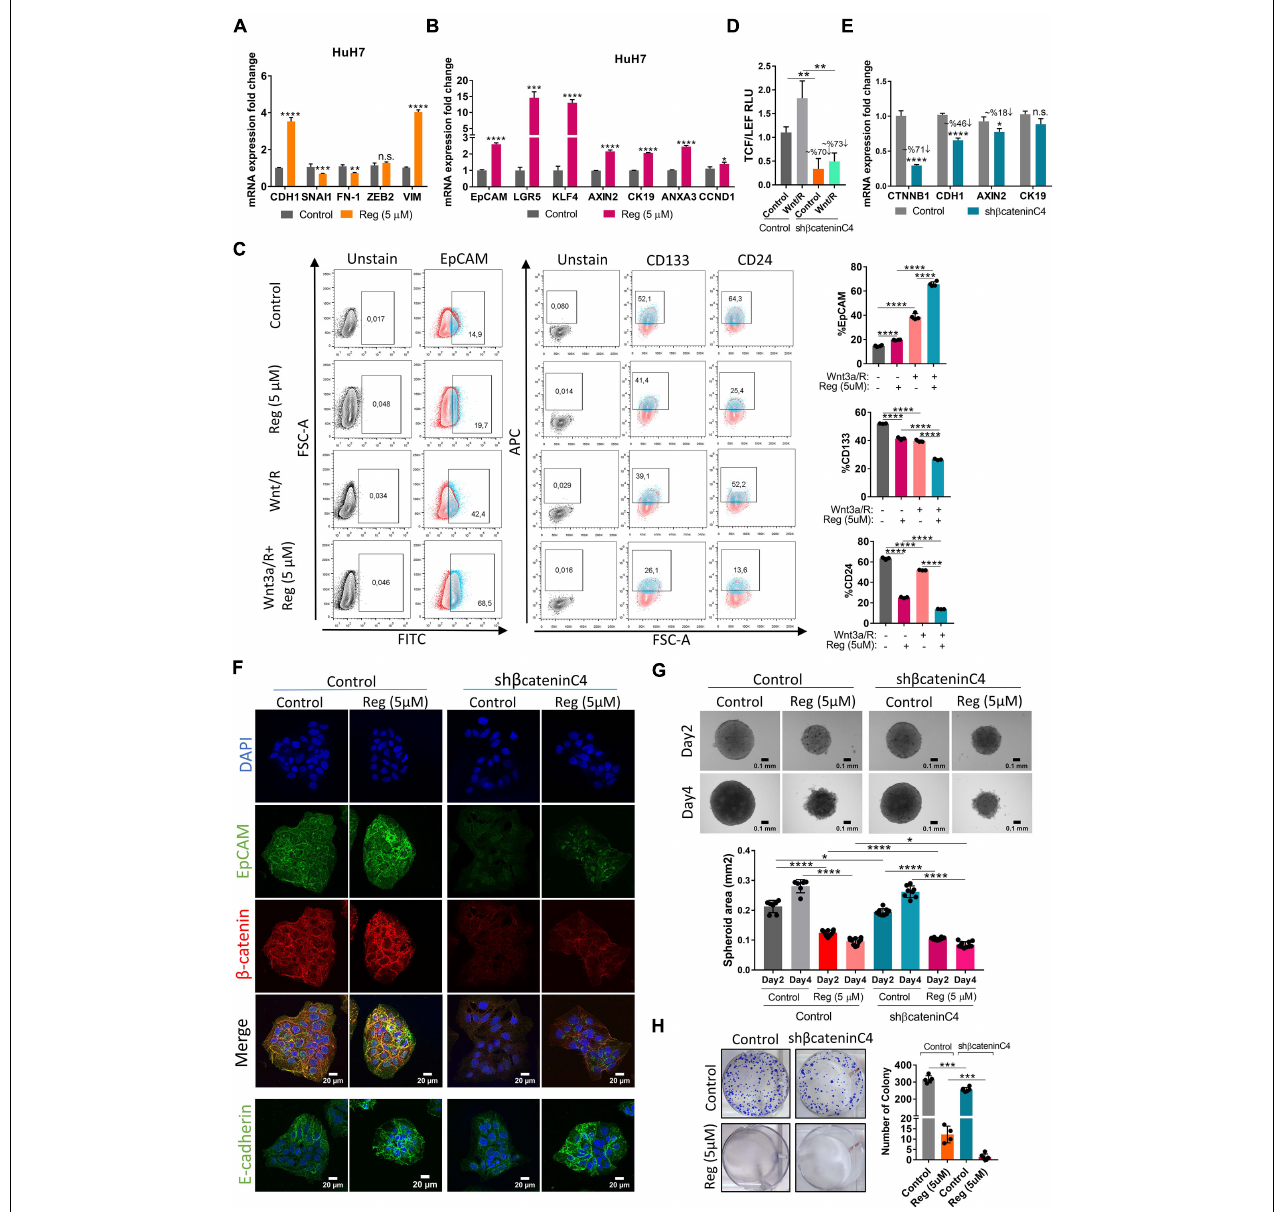
FIGURE 3 | Regorafenib treatment induces epithelial and stemness related gene expression. (A) Expression of mesenchymal and epithelial genes as well as (B) hepatic stem/progenitor genes were analyzed by q-PCR. Data represent the average of at least three independent experiments. (C) Cancer-stem cell marker (EpCAM, CD133 and CD24) positive cell populations were analyzed via BD LSR Fortessa flow cytometer with or without Wnt3a/R-Spo1 and regorafenib treatments. (D) TCF/LEF reporter activity in Wnt3a/R-Spo1 treated and untreated control and β -catenin knocked down cells (E) Expression of Wnt/ β -catenin target genes were analyzed by q-PCR. (F) Expressions of EpCAM, E-CAD and β -catenin were analyzed in control and β -catenin knocked down cells by immunofluorescence. Images were acquired on a Carl Zeiss LSM 880 AxioObserver confocal microscope with a C-Apochromat 40x/1.2 W, Korr FCS M27 objective. (G) 3D spheroids were formed from control and β -catenin knocked down cells with or without regorafenib treatment. Spheroid area was calculated using Image J. (H) Colony formation assay was performed using control and β -catenin knocked down cells with or without regorafenib treatment. p > 0.05 (n.s.), p ≤ 0.05 (*), p ≤ 0.01 (**), p ≤ 0.001 (***), p ≤ 0.0001 (****). Error bars indicate standard deviation